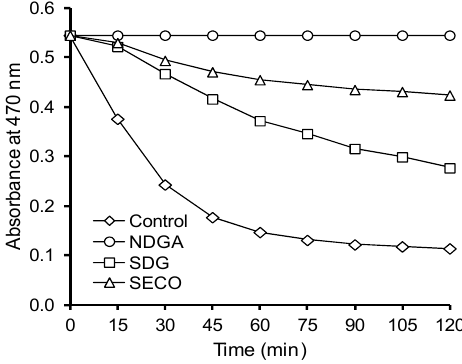
Figure 9. Antioxidant activity of SDG, SECO, and NDGA in β -carotene-linoleate emulsion system.